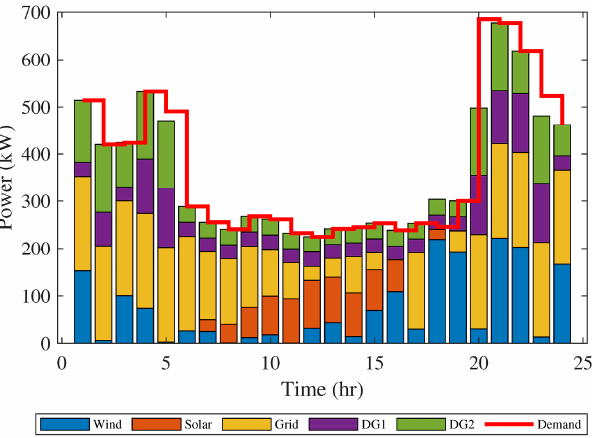
Figure 7. Case I: Microgrid generation scheduling for peak day with forecast